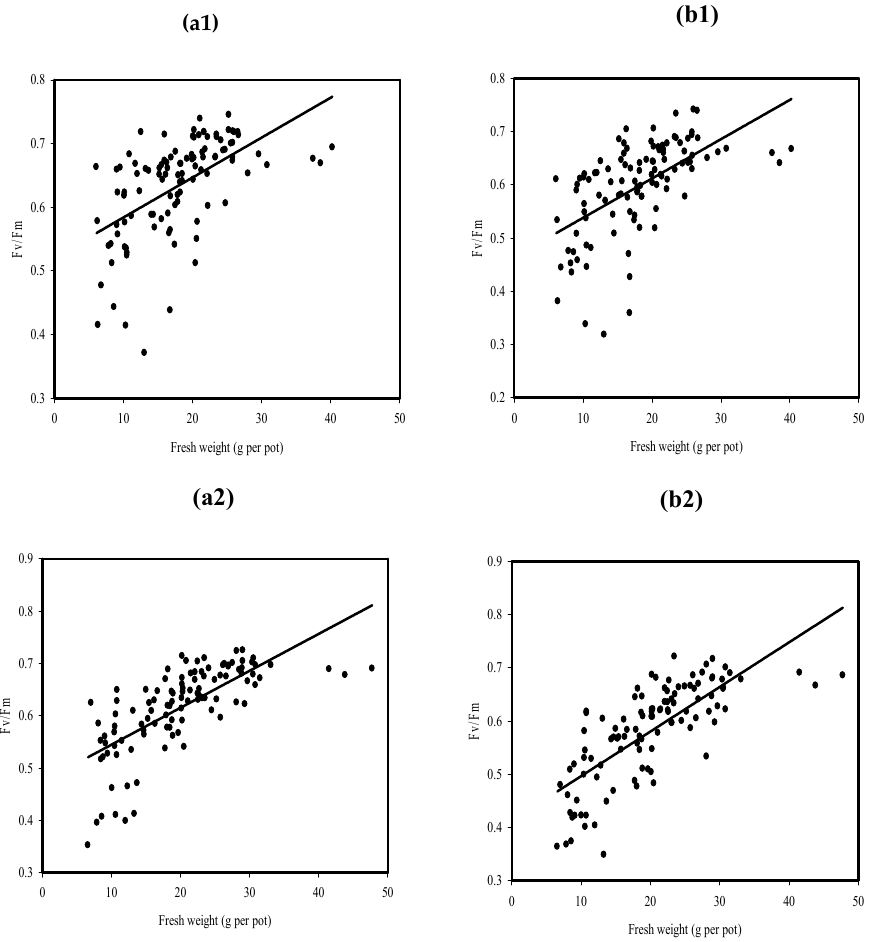
Figure 7. Linear regression of the maximum quantum photosystem II (F v /F m ) on Fresh weight, 4 days ( a1 , a2 ) and 8 ( b1 , b2 ) days after treatment in potato and fresh weight 3 weeks after treatment for metribuzin:flumioxain in first ( a ) and second experiment ( b ). Each data point on the graph represents one replication of potato with indifferent mixture